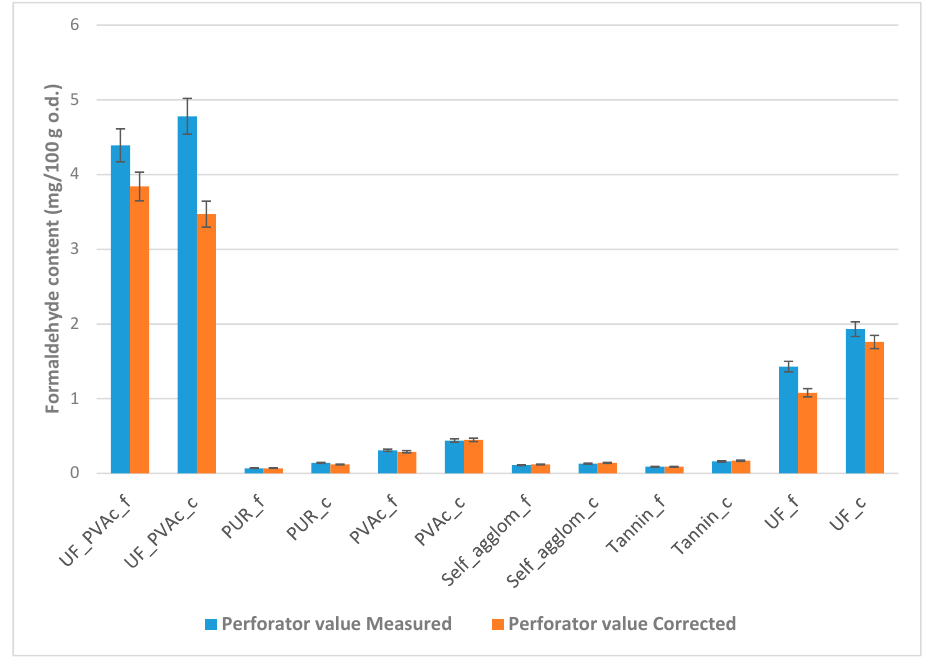
Figure 1. Free formaldehyde content for both measured and corrected perforator values (EN120:2011) of samples of larch-bark bonded decorative boards with six types of